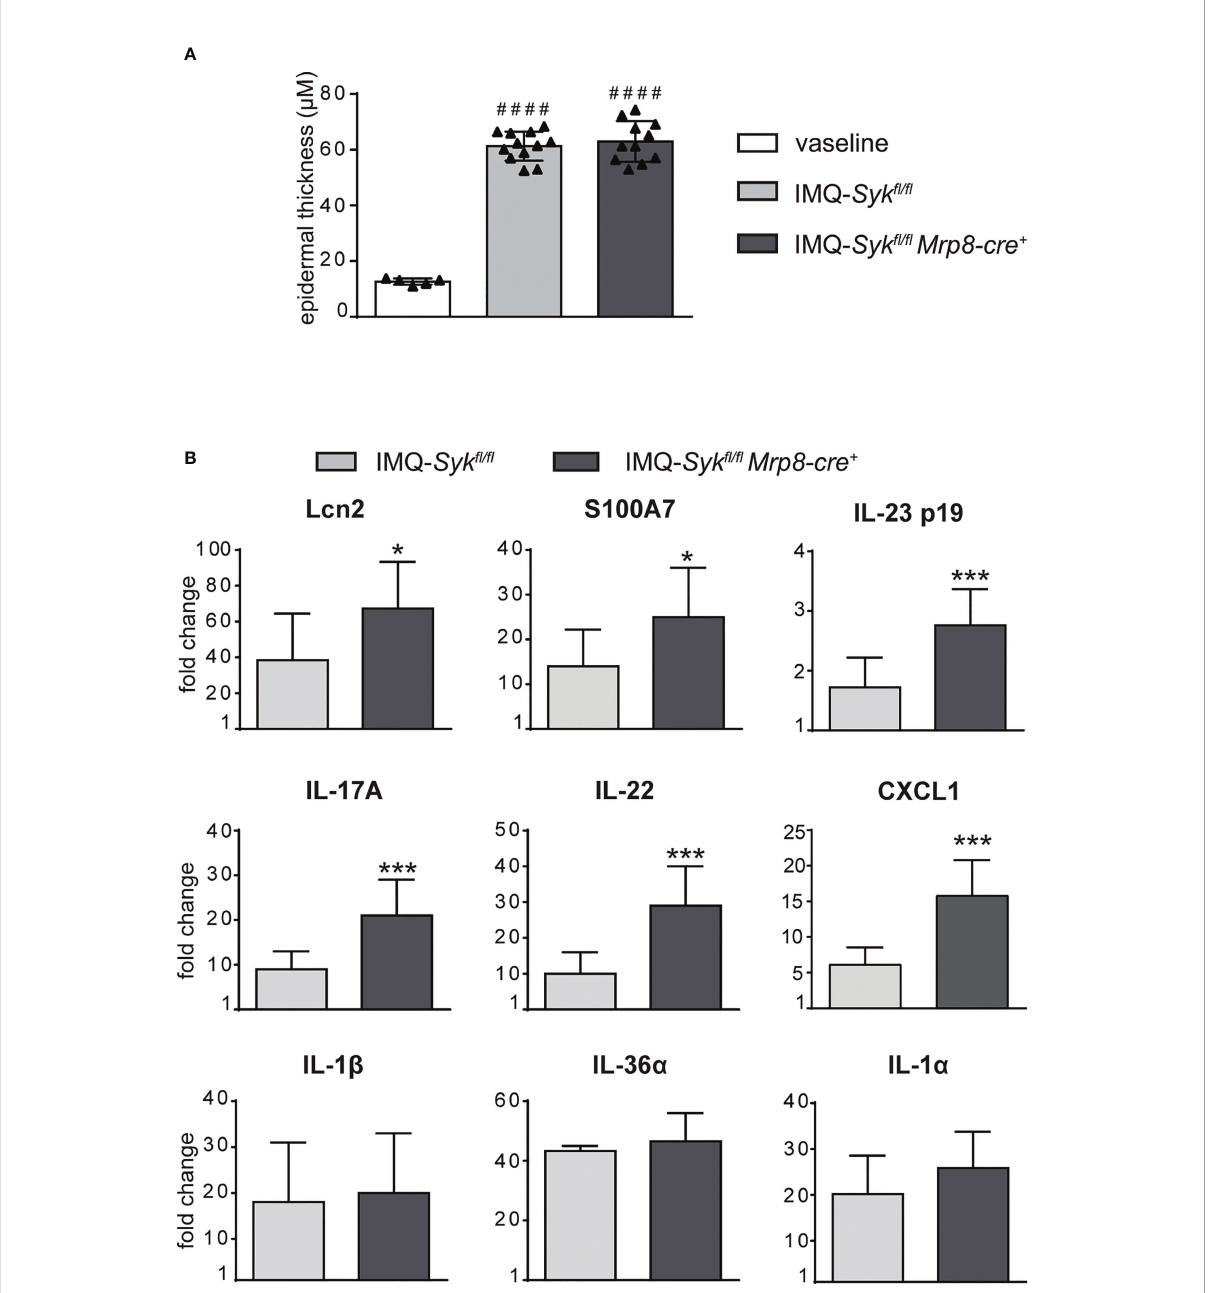
FIGURE 8 Epidermal thickening and gene-expression analysis of in fl ammatory molecules in the skin of IMQ-treated Syk fl / fl and Syk fl / fl Mrp8-cre + mice. The dorsal skin of control Syk fl / fl and Syk fl / fl Mrp8-cre + mice was topically treated with IMQ-containing cream (Aldara ® ) or Vaseline for 6 consecutive days. (A) The height of epidermal hyperplasia (epidermal thickening) was measured in the interfollicular epidermis on H&E-stained slides by light microscopic evaluation. (B) Total skin RNA was extracted and reverse transcribed. mRNA expression of the indicated genes for IMQ-treated Syk fl / fl and Syk fl / fl Mrp8-cre + mice is displayed as fold change of MNE units (after RPL32 normalization) over vaseline-treated controls. Data are pooled from 2 separate experiments and are expressed as means ± SD (n = 11 mice). Statistical differences of IMQ-treated Syk fl / fl or Syk fl / fl Mrp8- cre + mice vs . vaseline-treated mice (#) and IMQ-treated Syk fl / fl vs . IMQ-treated Syk fl / fl Mrp8-cre + mice (*) are reported. #### P ≤ 0.0001 by 1- way ANOVA with Bonferroni ’ s post-test. * P ≤ 0.05; *** P ≤ 0.001 by t-